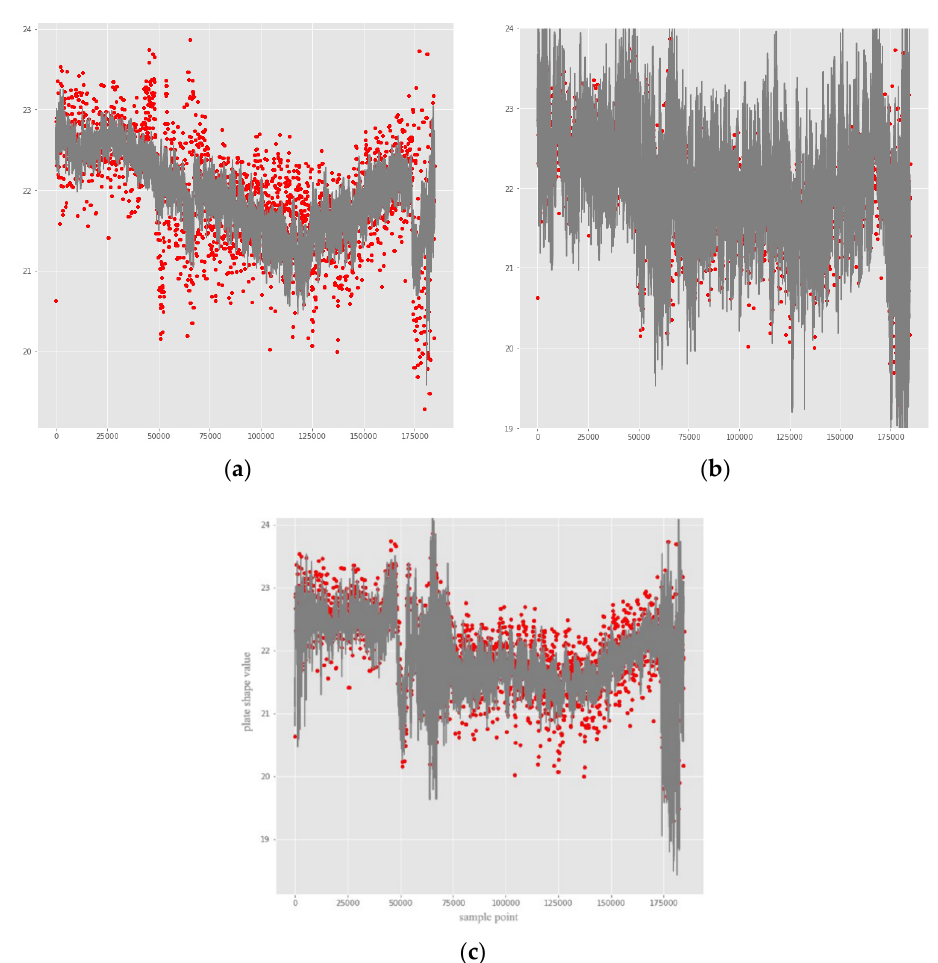
Figure 6. Comparison of real and predicted values. ( a ) BP; ( b ) DNN; ( c ) Improved DNN. The horizontal axis represents sample points (0~175,000), and the vertical axis represents the predicted plastic shape value (18~24).